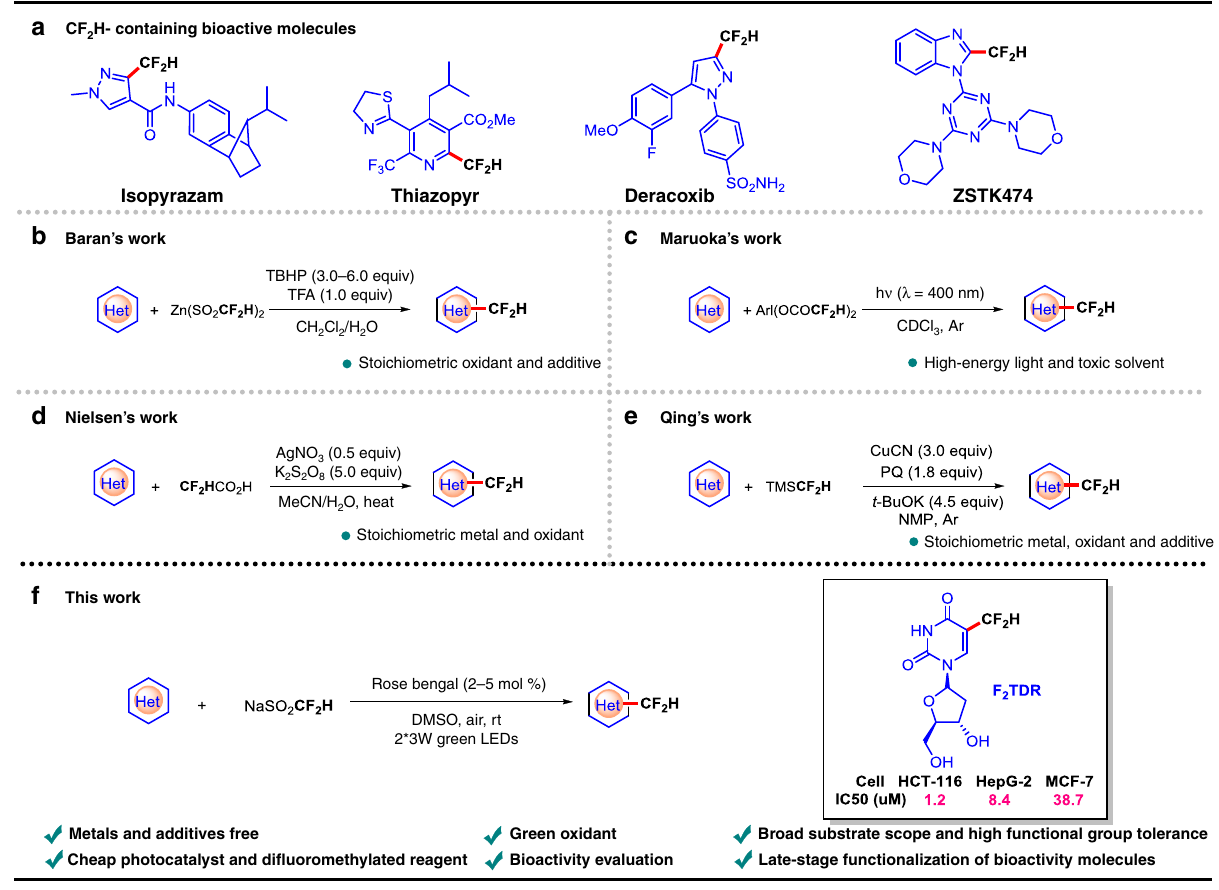
Fig. 1 Construction of CF 2 H-containing heterocycles. a Examples of CF 2 H- bioactive molecules. b TBHP promoted direct di fl uoromethylation of heterocycles. c High-energy light promoted direct di fl uoromethylation of heterocycles. d Ag and K 2 S 2 O 8 co-catalyzed direct di fl uoromethylation of heterocycles. e Cu and PQ co-catalyzed direct di fl uoromethylation of heterocycles. f Organic photoredox catalysis triggered direct di fl uoromethylation of